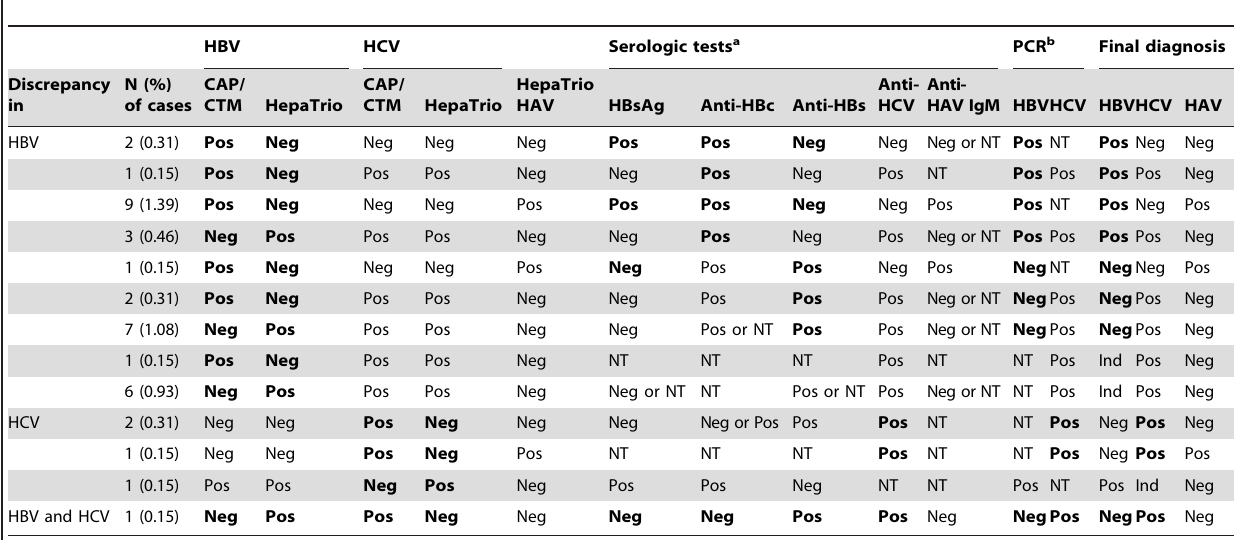
Table 2. Summary of discrepant cases between the HepaTrio and the CAP/CTM assays.